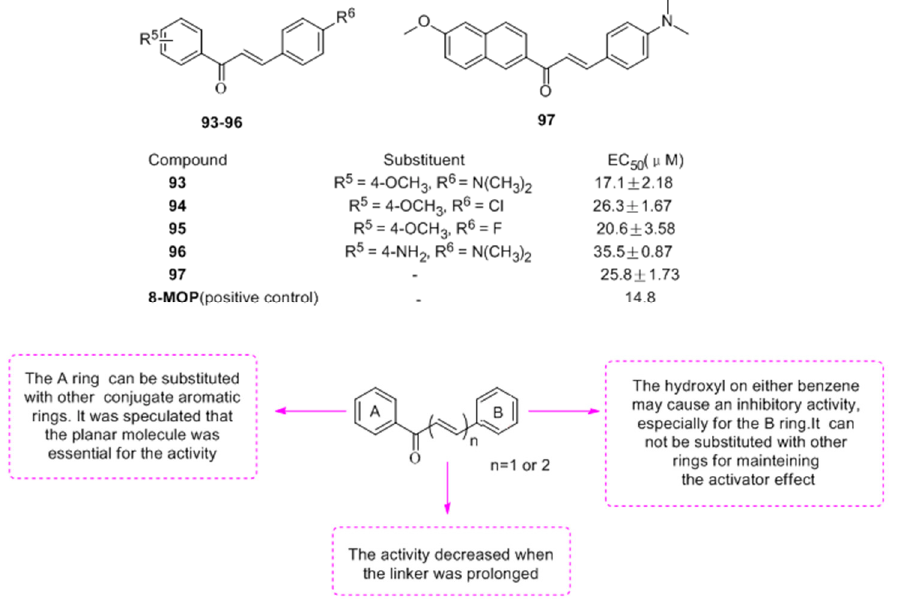
Figure 11. Structures of the chalcones with activator effect and SAR.